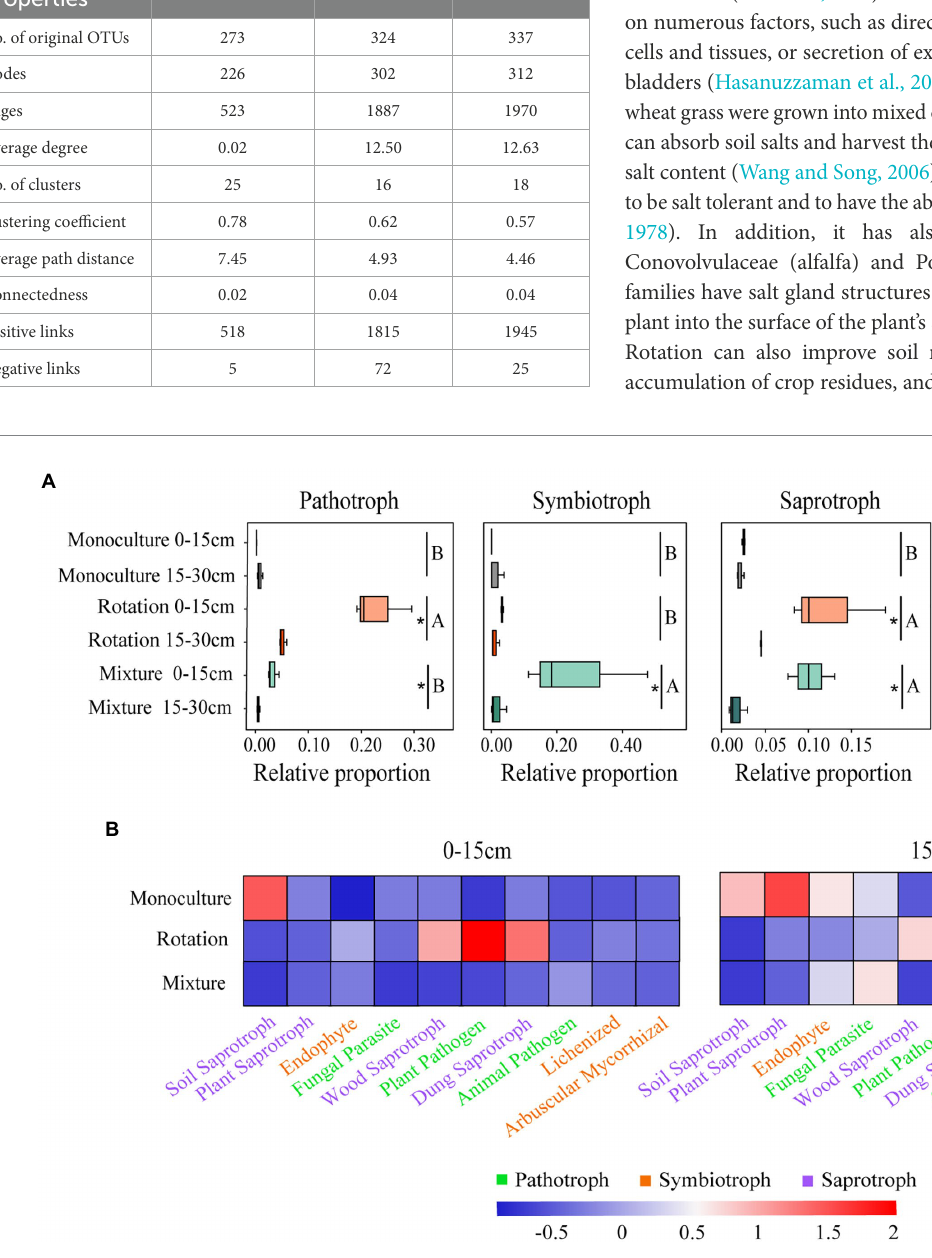
TABLE 2 Major topological properties of the co-occurrence network of soil fungal communities. Topological properties